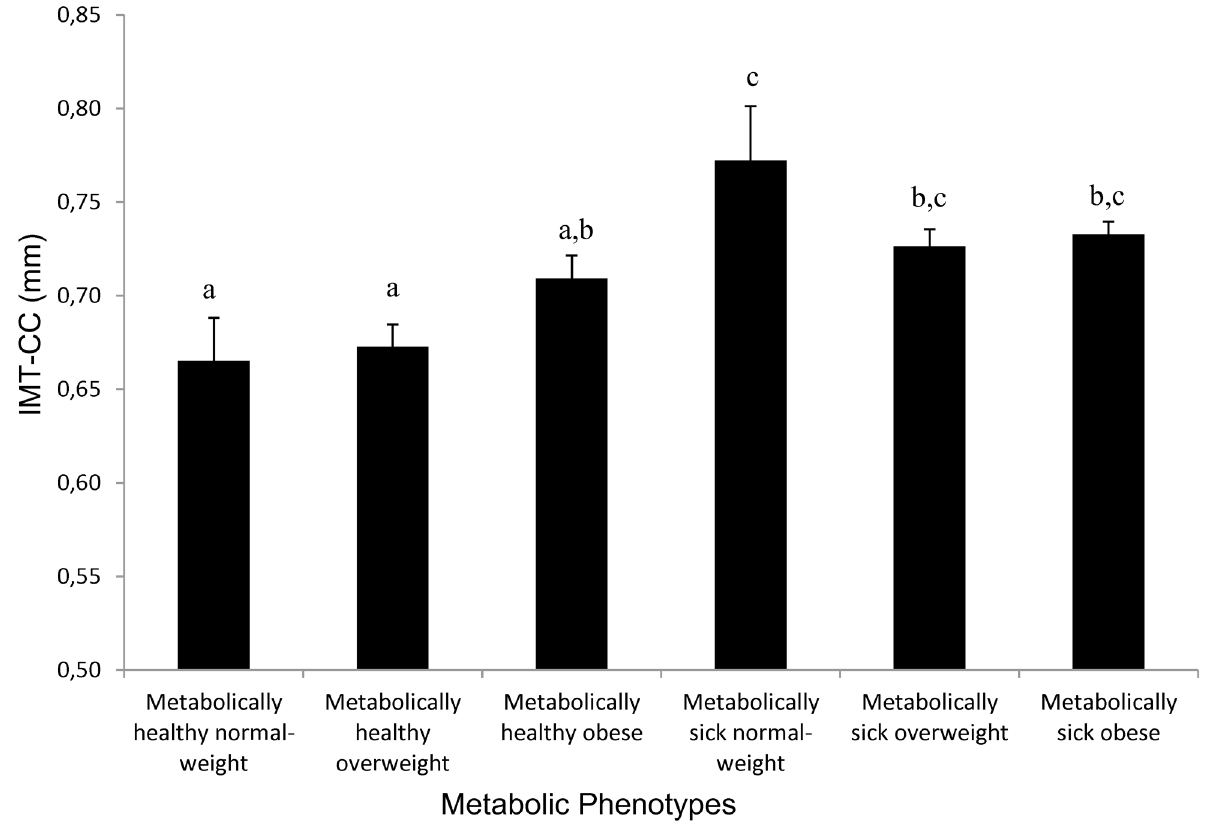
Fig 2. Influence of metabolic phenotypes on IMT-CC of coronary patients in the CordioPrev study. All data are Mean +/- SEM (mm). Columns which do not share at least one letter are different at p < 0.05. Sample size for the different groups is as follows: Metabolically healthy normal-weight (n = 36); metabolically sick normal-weight (n = 22); metabolically healthy overweight (n = 136); metabolically sick overweight (n = 221); metabolically healthy obese subjects (n = 122); metabolically sick obese subjects (n = 402). Specific p values for the different significant comparisons are as follows: Metabolically healthy normal-weight subjects are different to metabolically sick normal-weight (p = 0.0036), metabolically sick overweight (p = 0.0134) and metabolically sick obese subjects (p = 0.0048); Metabolically healthy overweight subjects are different to metabolically sick normal-weight (p = 0.0014), metabolically sick overweight (p = 0.0004) and metabolically sick obese subjects (p = 0.0001).